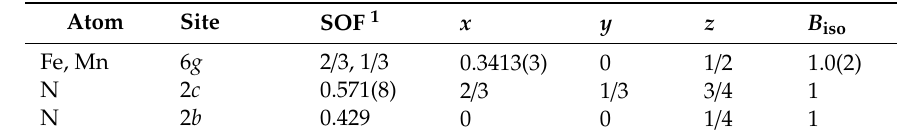
Table 2. Wyckoff positions, site occupancy factors (SOF), relative atomic coordinates and isotropic displacement parameters B iso (in 10 4 pm 2 ).